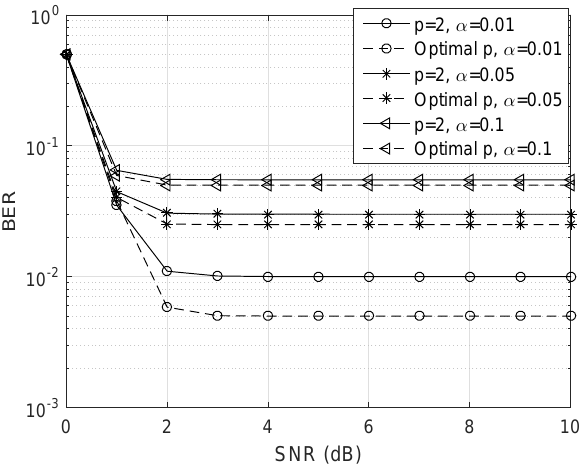
Figure 4. BER versus SNR γ . We observe that BER achieves the maximum at γ = 0. The designed detector can perform well even when the SNR is high. In both detector schemes, the BER remains unchanged despite of large SNR because of strong direct-link interference [8] or SNR wall problem [17].